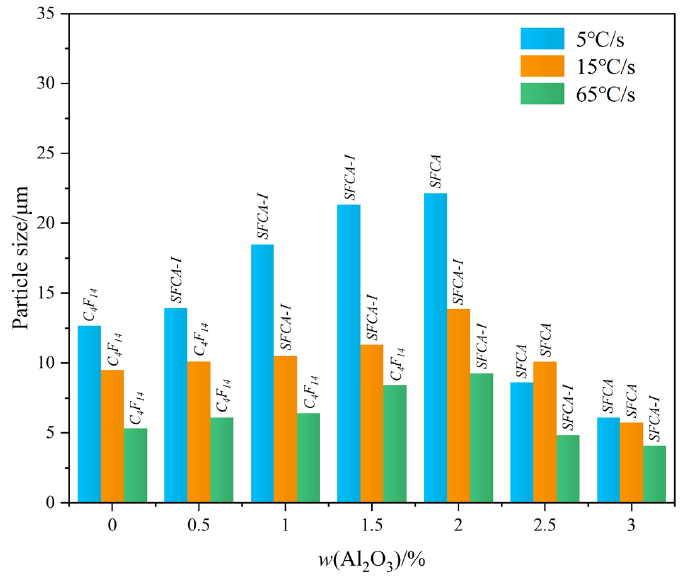
Figure 13. Crystal size of calcium ferrite (C 4 F 14 , SFCA-I, SFCA) at different cooling rates.